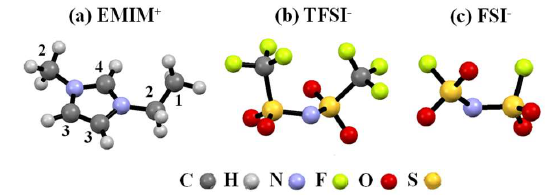
Fig. 1. Structural formula of (a) EMIM + cation, (b) TFSI - and (c) FSI - anions.